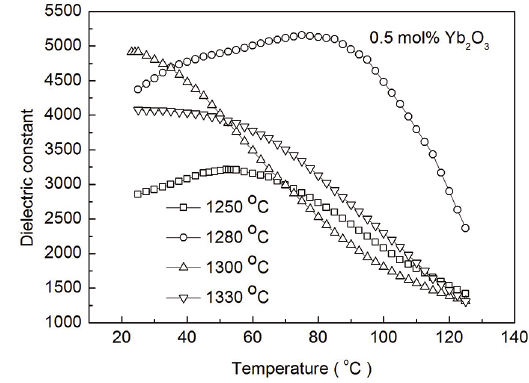
O ceramics sintered 2 3